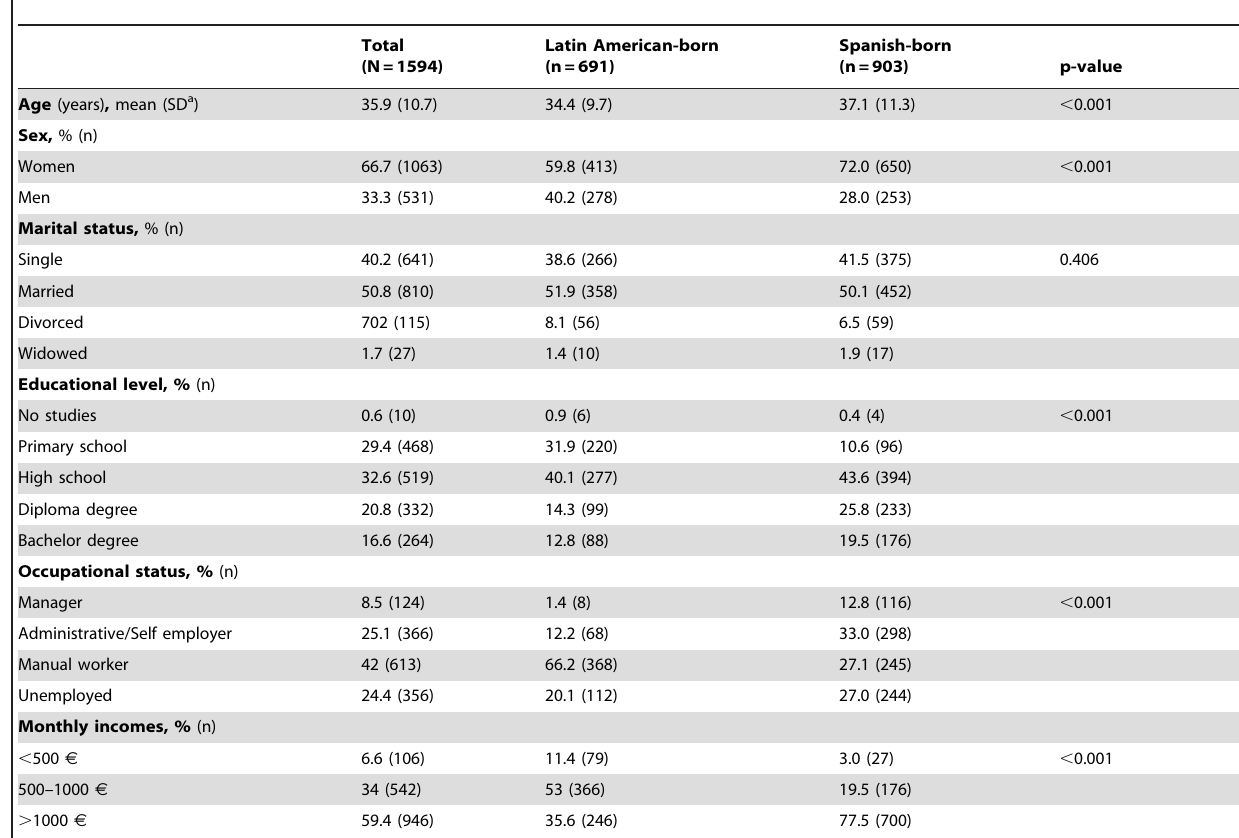
Table 1. Distribution of sociodemographic characteristics of the study population, stratified by country of